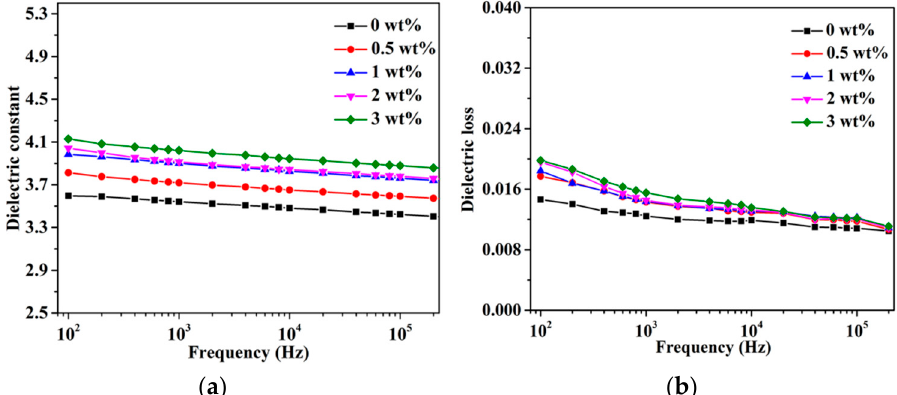
Figure 12. Frequency dependences of ( a ) dielectric constant and ( b ) dielectric loss of the nanocomposites films with various h-BN@(PDA+PEI) contents.